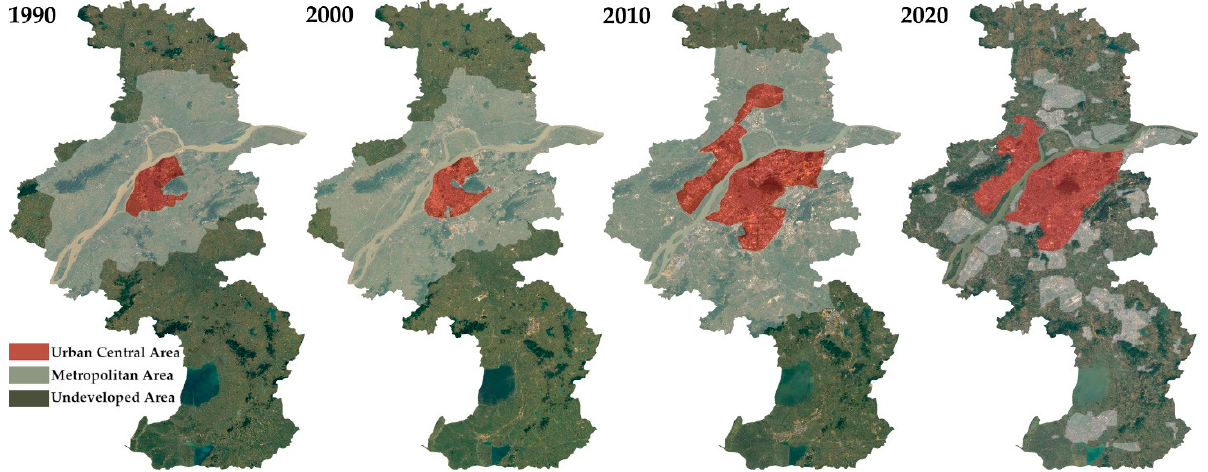
Figure 5. The change in boundary of urban growth in Nanjing over time (Figure source: own draw- ing; data from: [87-89]). data from: